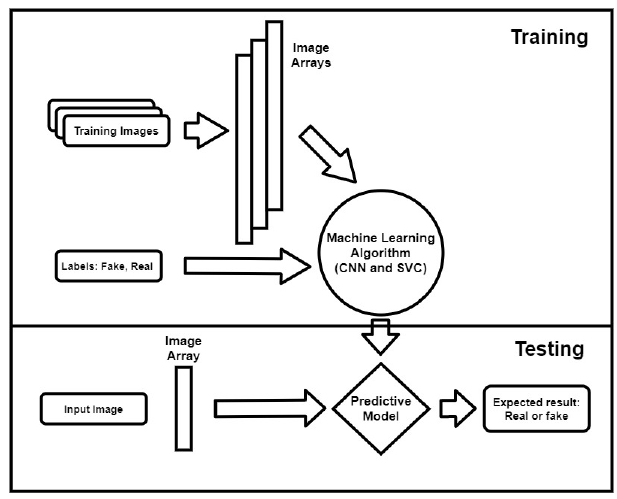
Figure 3. Block Diagram of the Proposed System Figure 1. Working of Convolution Neural Network